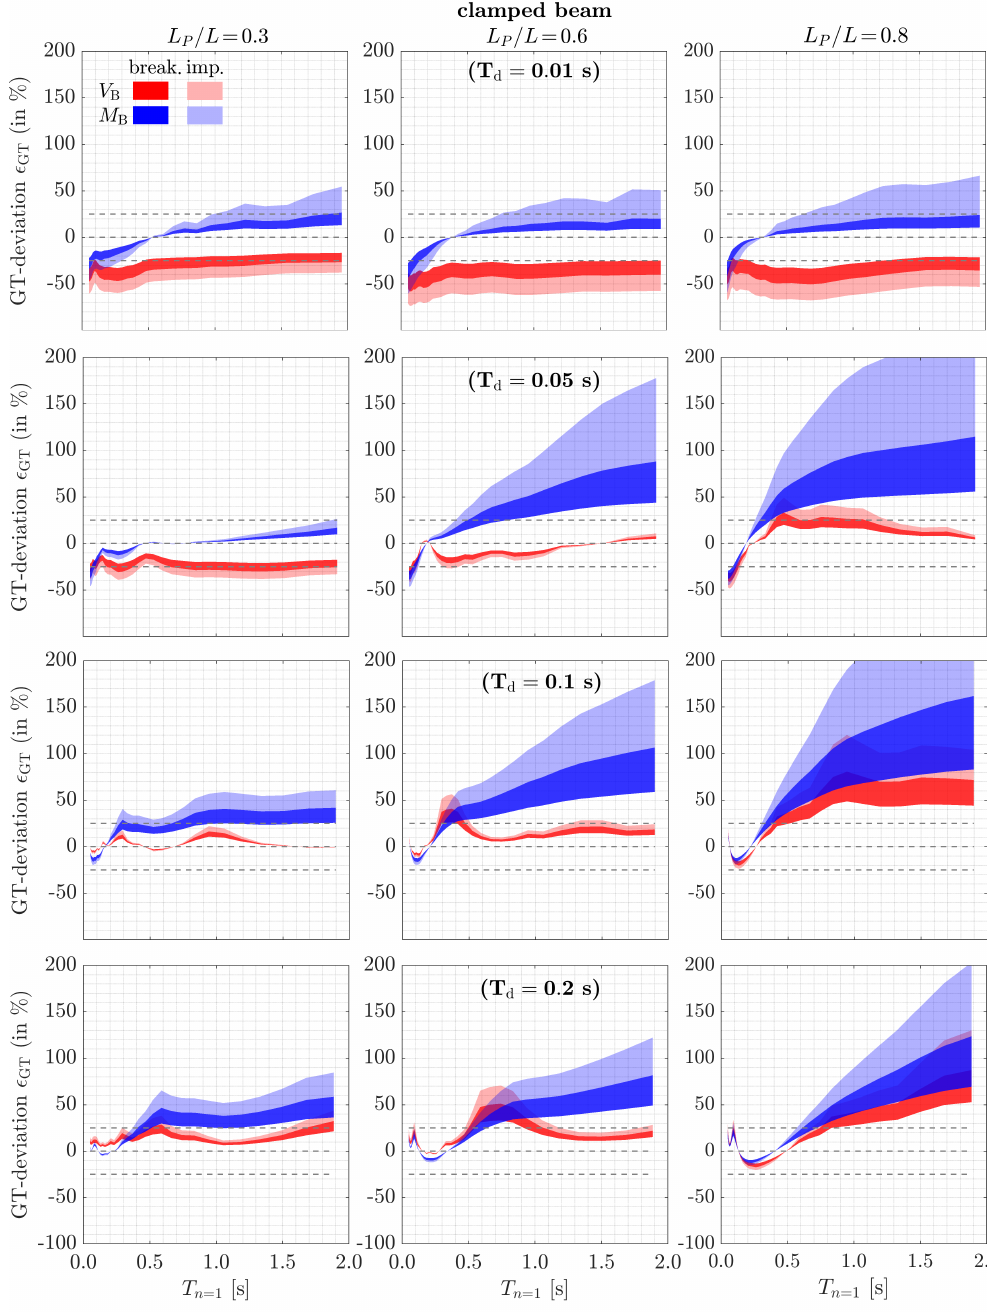
Figure 14. GT-deviations for clamped beam such as calculated in this